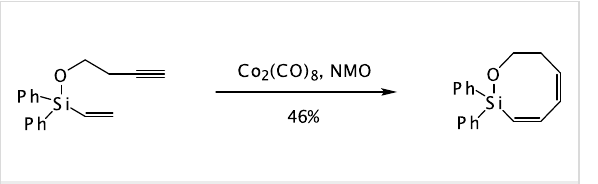
Scheme 1: Saigo's cycloisomerisation reaction under Pauson-Khand